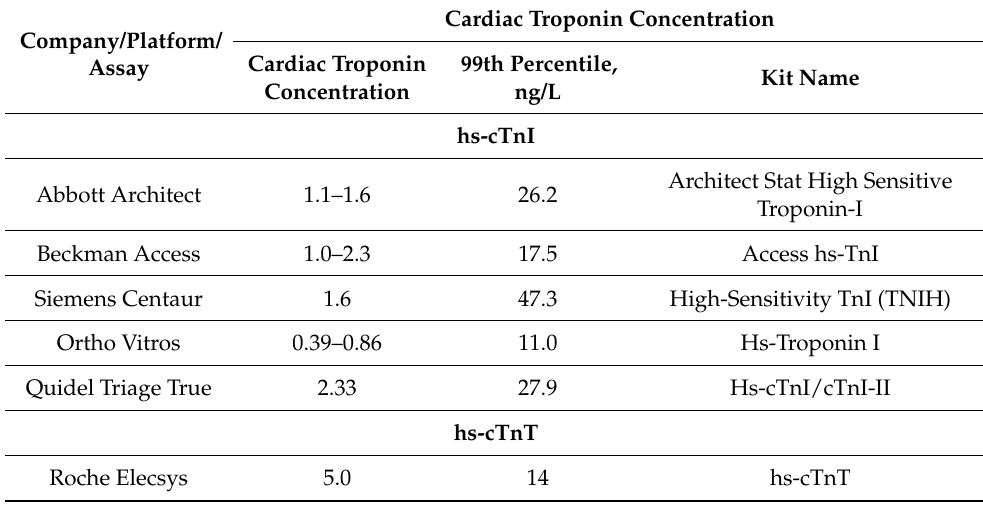
Table 1. Analytical characteristics of high-sensitivity cardiac troponin assays modified from Pudil R [5]. Cardiac Troponin Concentration Company/Platform/ Cardiac Troponin 99th Percentile, Assay Concentration